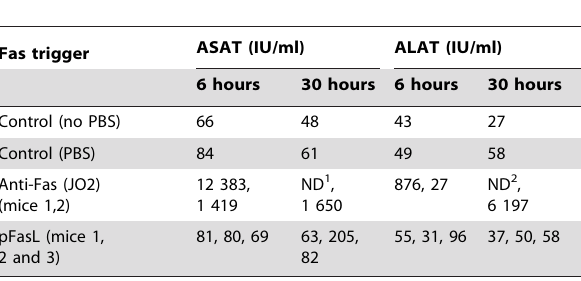
Table 2. pFasL does not induce liver